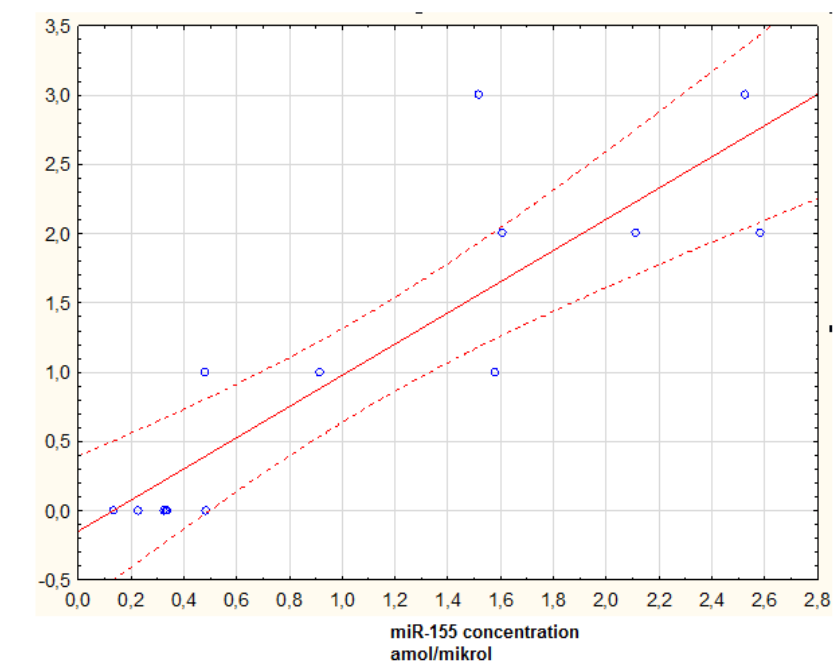
Figure 3. Scatterplot of miR-155 concentration versus PD-L1 expression level. p = 0.00087; p < 0.05. Blue dot—data, solid red line—regression line, dotted red line—95% CI.